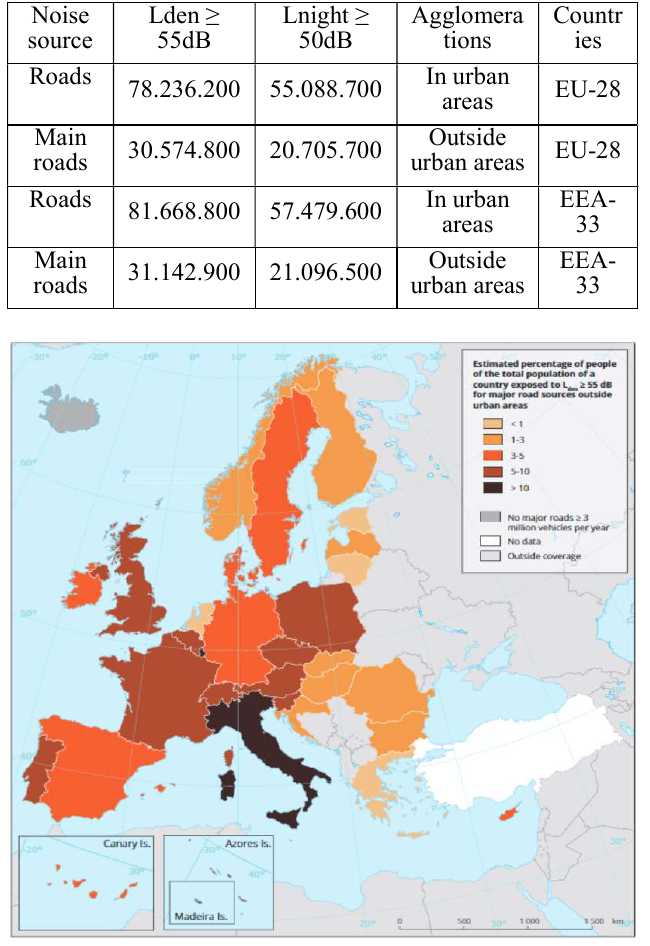
Figure 1. Estimated percentage of the total population of the country exposed to Lden ≥ 55 dB of road traffic on major roads outside urban areas in 2017